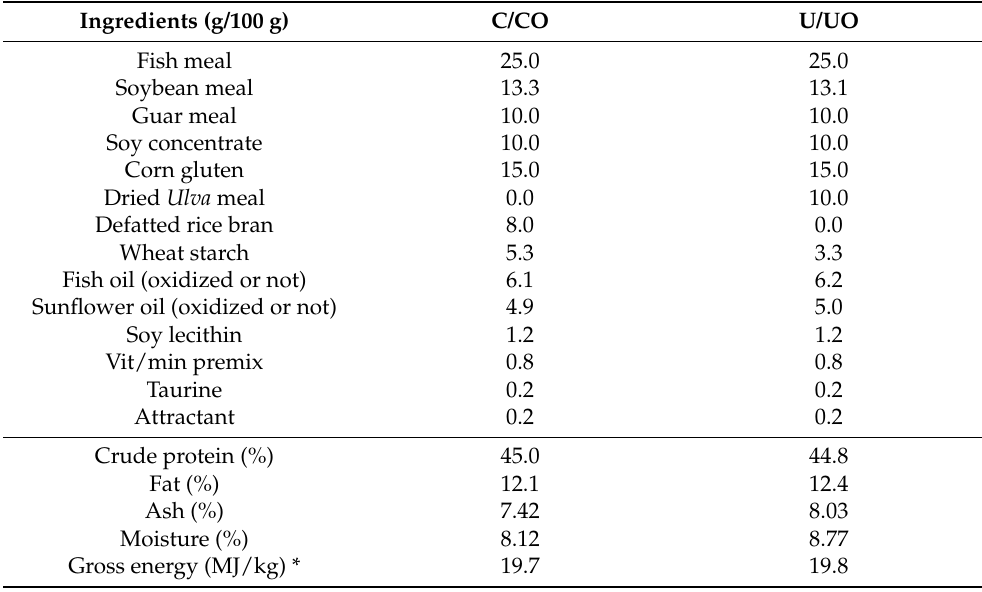
Table 2. Ingredients and proximal composition of the four feeds used in Experiment 3. (*) Gross energy was estimated from nutrient